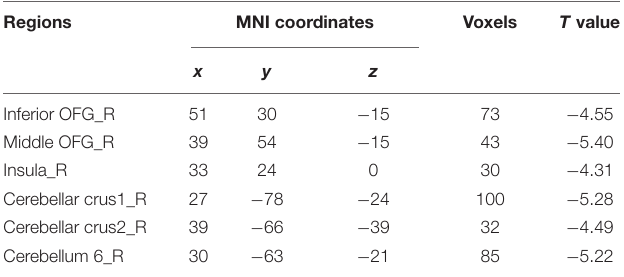
TABLE 2 | Brain regions showing significantly decreased INT between mTLE patients and HC subjects (GRF corrected, P voxel < 0.001, P cluster < 0.05, voxel wise ≥